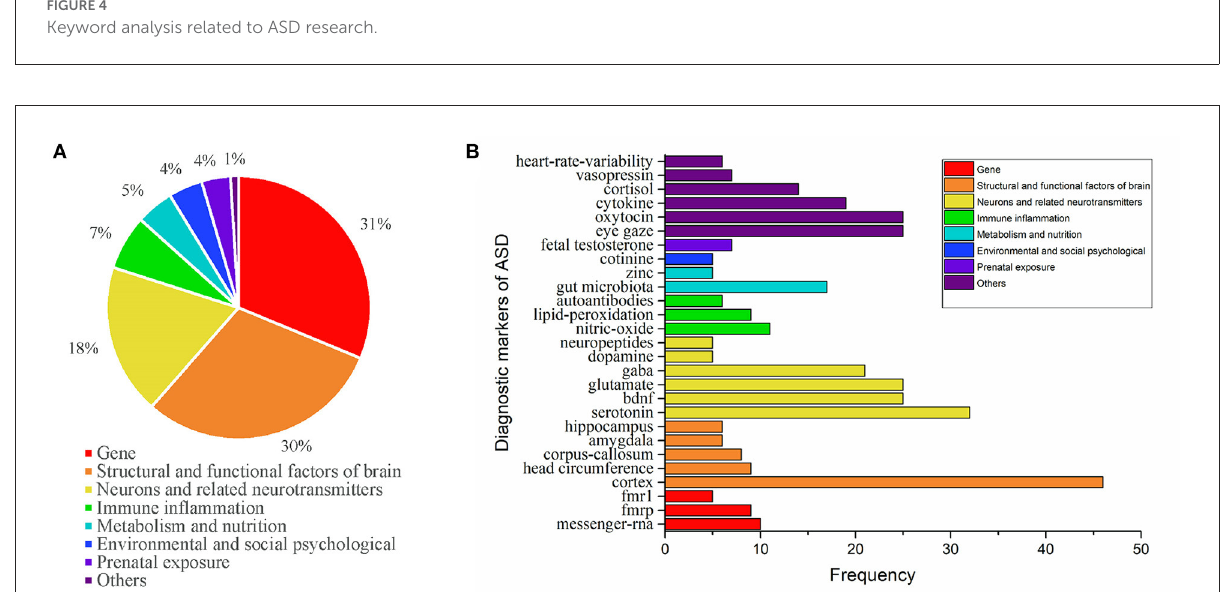
FIGURE4 Keyword analysis related to ASD